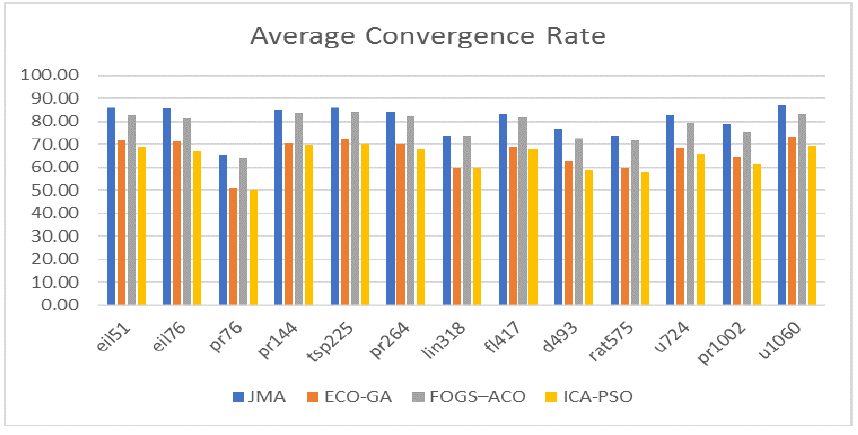
Figure 6. Average convergence